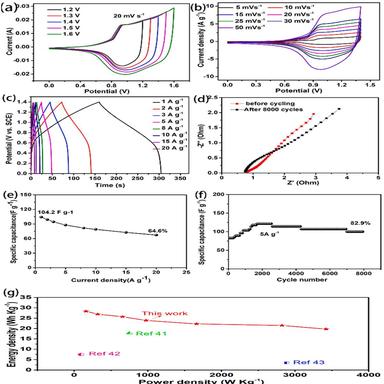
(a) CV curves of the MCO@NS // AC ASCs cell tested under different potential windows. (b) ASCs' CV curves under various scanning rates. (c) ASCs' GCD curves under different current densities (d) EIS of ASC before and after 8000 cycles. (e) Current density dependence of ASCs' specific capacitance. (f) The cycle effect of the ASCs under a constant current density under 8000 cycles. (g) Ragone plot correlated with ASCs' energy and power densities.